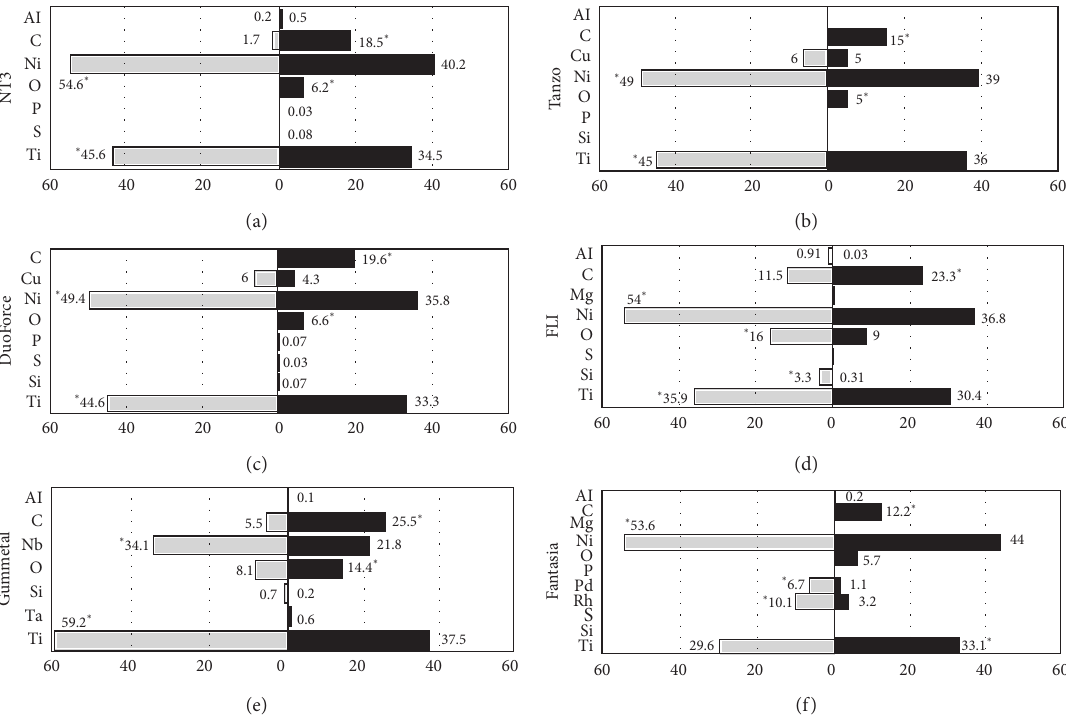
Figure 2: Chemical composition of six wires analysed: in the graphics, observed changes in the elemental composition (%) of NT3 ® (a), Tanzo ® (b), DuoForce ® (c), FLI ® (d), Gummetal ® (e), and Fantasia ® wires (f) before and after their use in the mouth, ∗ p ≤ 0 .